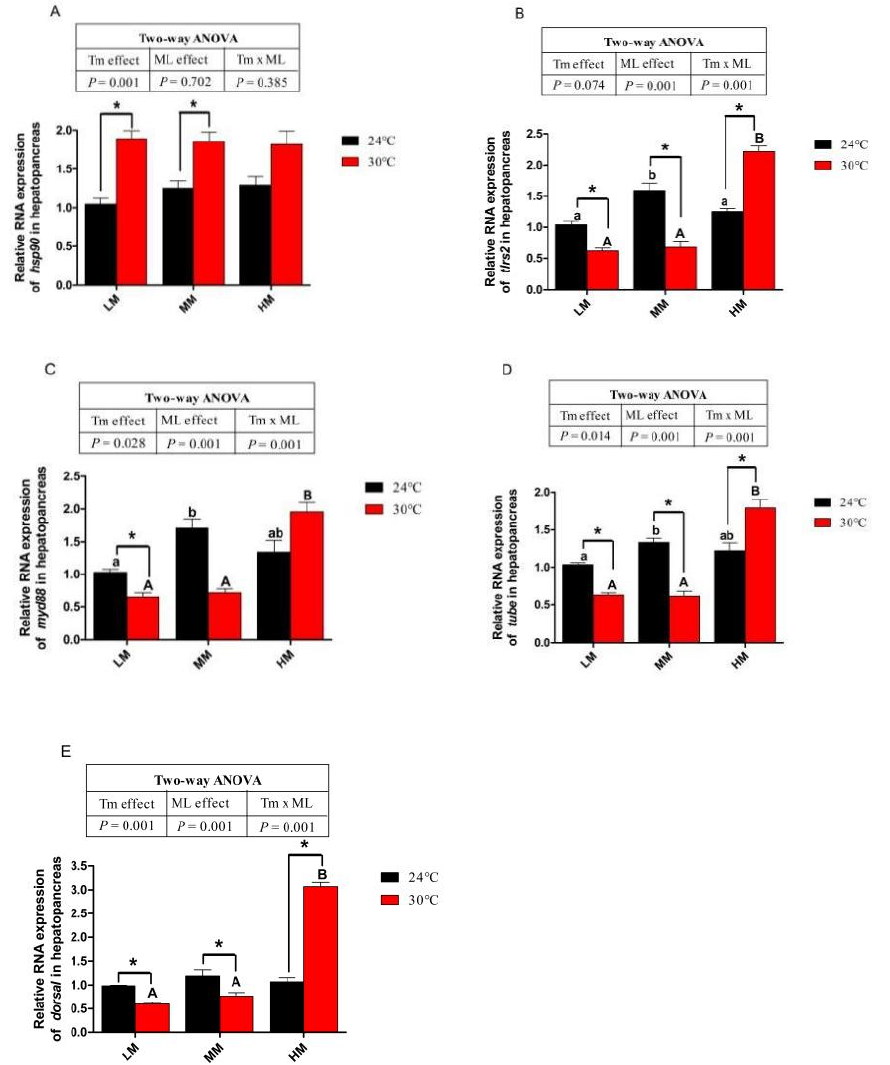
Figure 6. The toll-like receptor-related pathway of juvenile E. sinensis fed the experimental diets at normal water temperature (24 ◦ C)/high water temperature (30 ◦ C). ( A ) Hsp90 : heat shock protein 90; ( B ) tlr2 : toll-like receptor 2; ( C ) myd88 : myeloid differentiation factor 88; ( D ) tube ; ( E ) dorsal . * means that there is a significant difference between different temperatures at the same dietary methionine level ( p < 0.05). The a and b indicate significant differences among crabs fed diets with different dietary methionine levels at normal temperature ( p < 0.05). The A and B indicate significant differences among crabs fed diets with different dietary methionine levels at high water temperature ( p < 0.05).